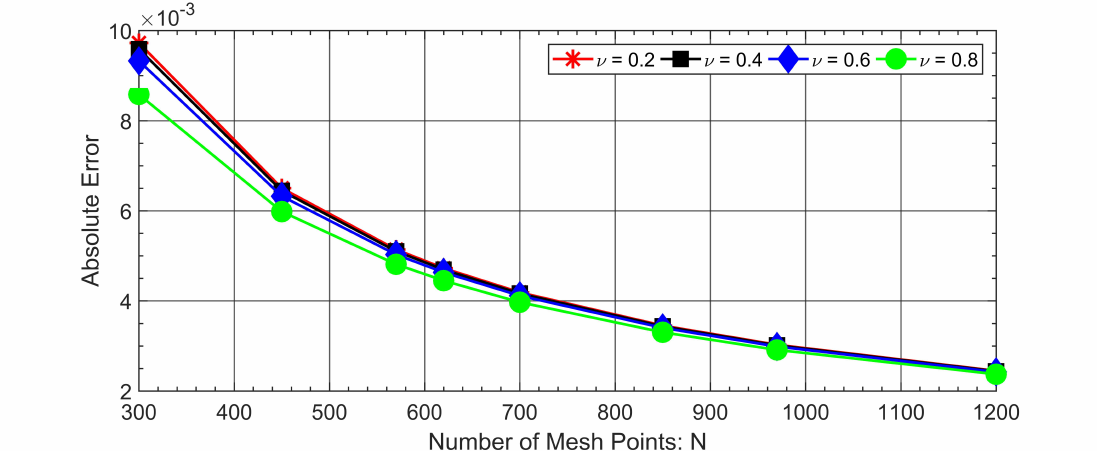
Figure 5. Absolute errors vs. number of mesh points N for the approximation of continuous uniform mesh for a temporal variable using the Caputo-Fabrizio operator for Problem 7 with varying fractional order ν .